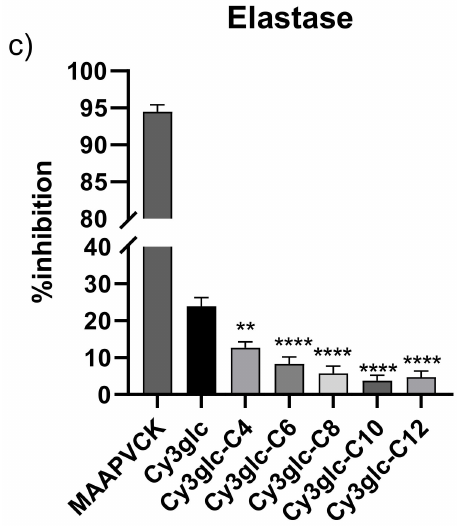
Figure 5. Inhibitory activity of lipophilic compounds at 50 µ M against ( a ) tyrosinase, ( b ) collagenase ( c ) elastase enzymes. For each enzyme a positive control was included as indicated in Section 2. Statistical comparisons were performed using Cy3glc as control. * p < 0.05, ** p < 0.01, *** p < 0.001 and **** p < 0.0001.